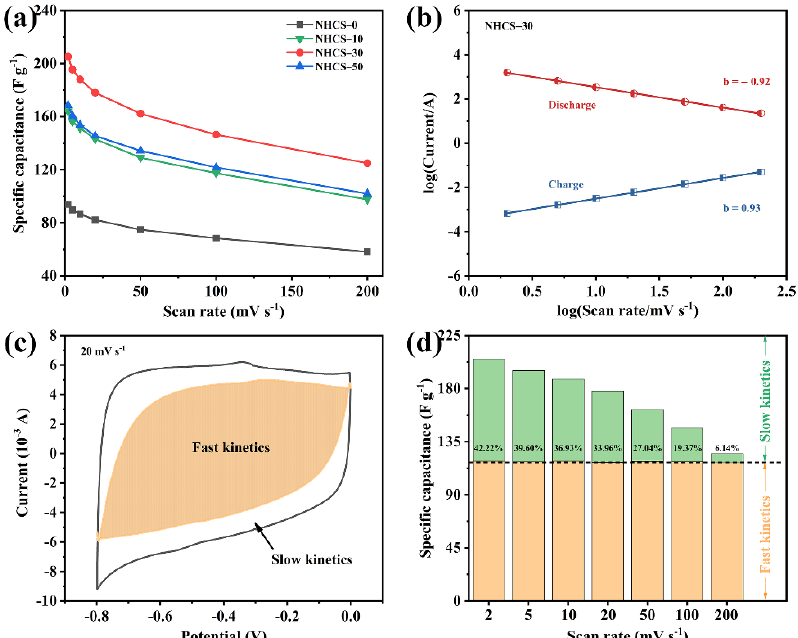
Figure 5. ( a ) Specific capacitance of NHCS- m at different scan rates; ( b ) Relationship between log(current) and log(scan rate) in the charge/discharge process for NHCS-30; ( c ) Decoupling of the capacity contributed by the fast kinetic process (shadow); ( d ) Histograms of capacitive contribution ratio for NHCS-30 at various scan rates.